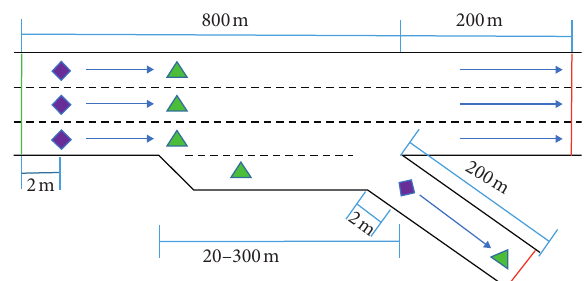
Figure 4: VISSIM simulation model parameter settings sketch for off-ramp area.